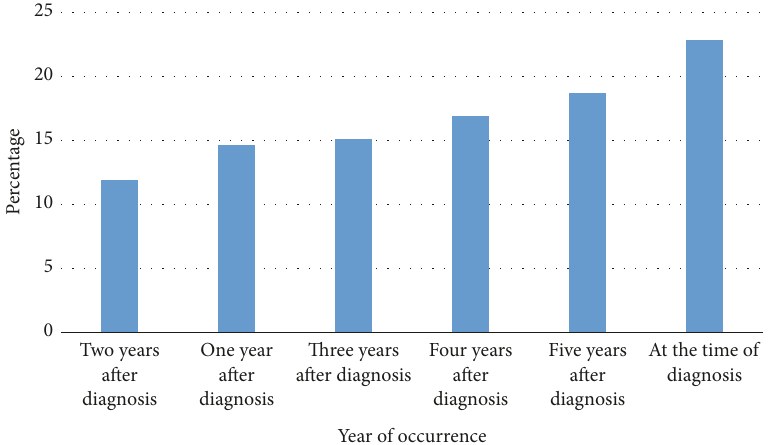
Figure 2: The occurrence of hypertensive complications each year.